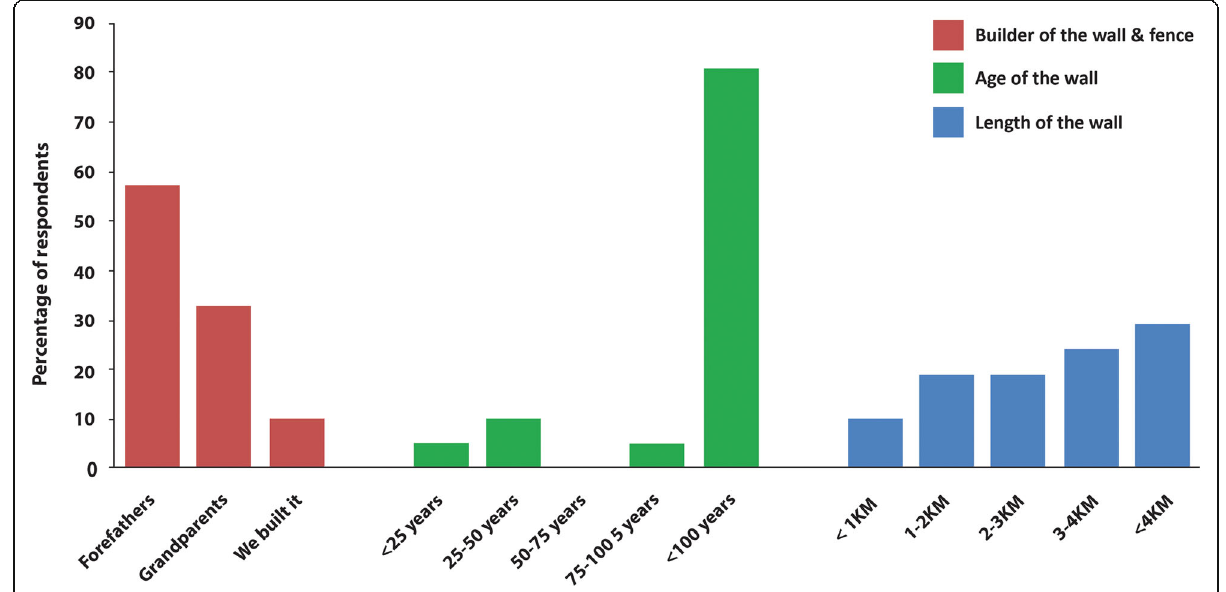
Figure 5 Historical characteristics of the